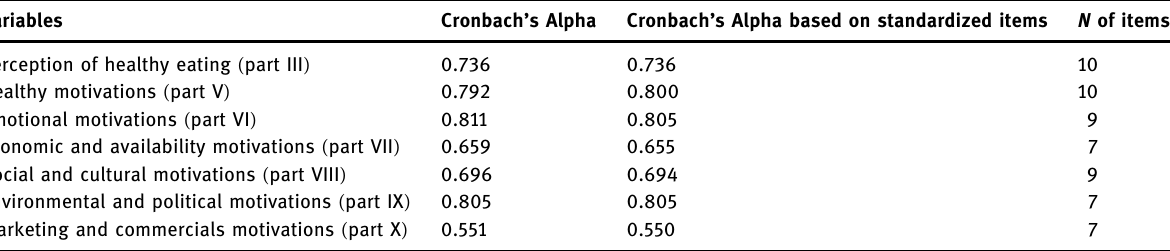
Table 3: Reliability analysis to the variables food motivations and perception of healthy eating